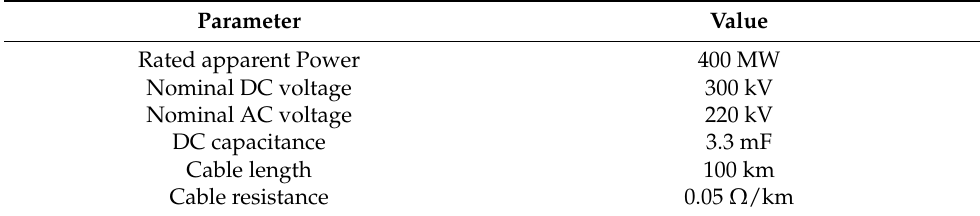
Table 2. The parameters of VSC-HVDC.